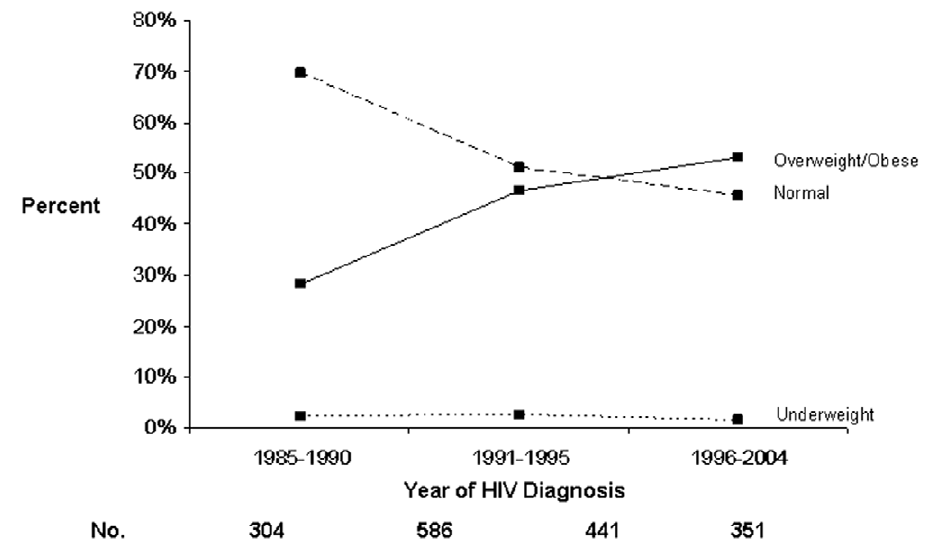
Figure 1. Trends in Weight Categories at HIV Diagnosis during the HIV Epidemic.